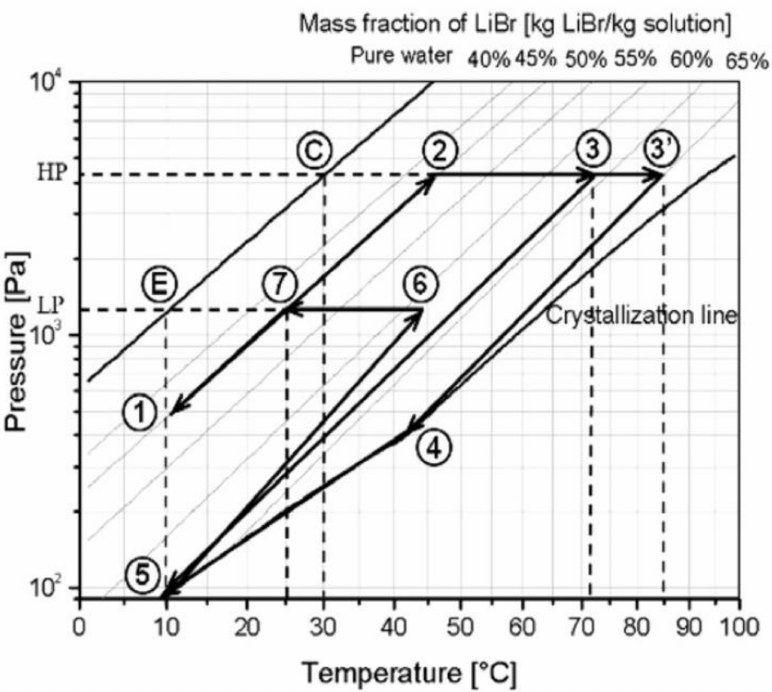
Figure 12. Working principle of LiBr/H 2 O with a conventional crystallization cycle